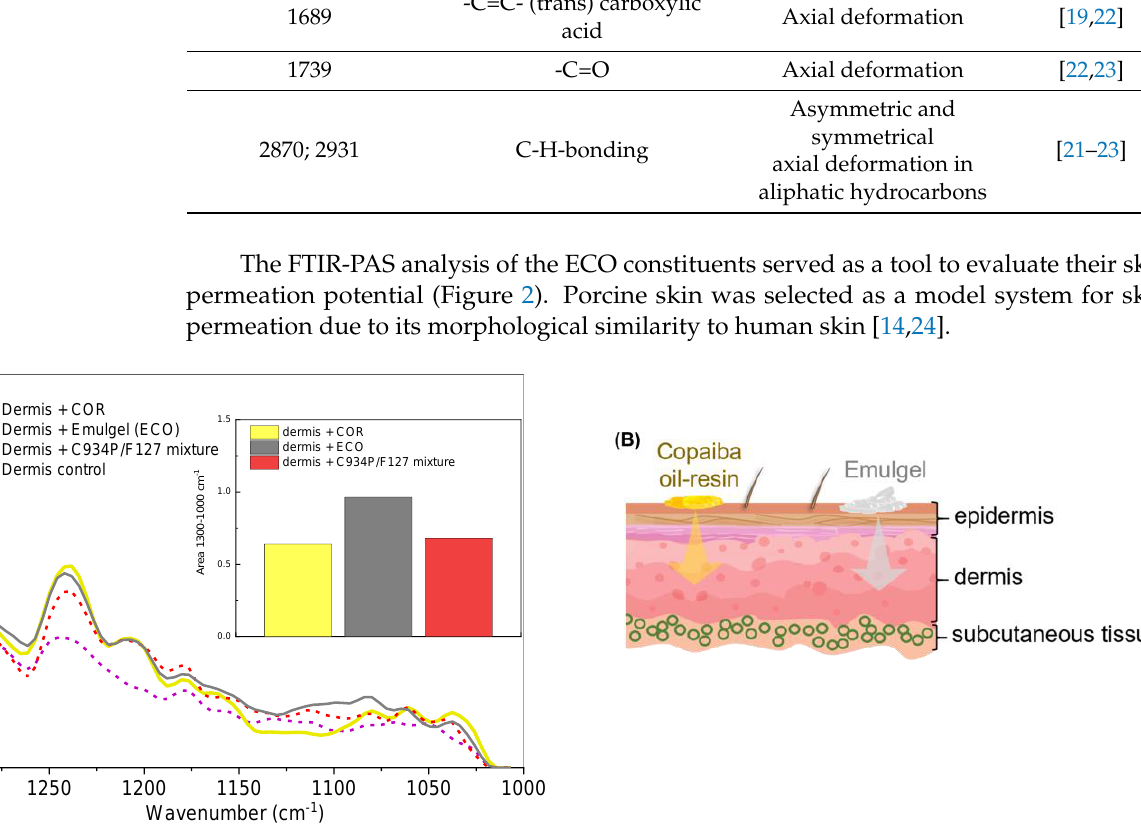
Figure 2. ( A ) Normalized FTIR-PAS signal of the COR, ECO, C934P/F127 mixture, and dermis control, acquired at 25 ◦ C. The insert in ( A ) demonstrates the difference between the areas of the spectra. ( B ) Schematic representation of the skin permeation of COR and ECO.